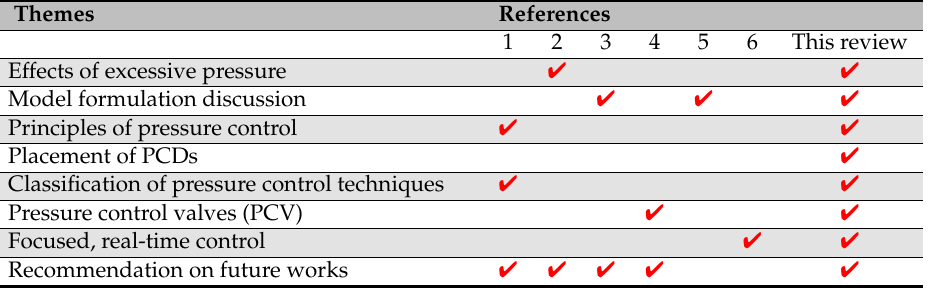
Table 1. Comparison of previous reviews/surveys in the pressure control domain. PCD, pressure control